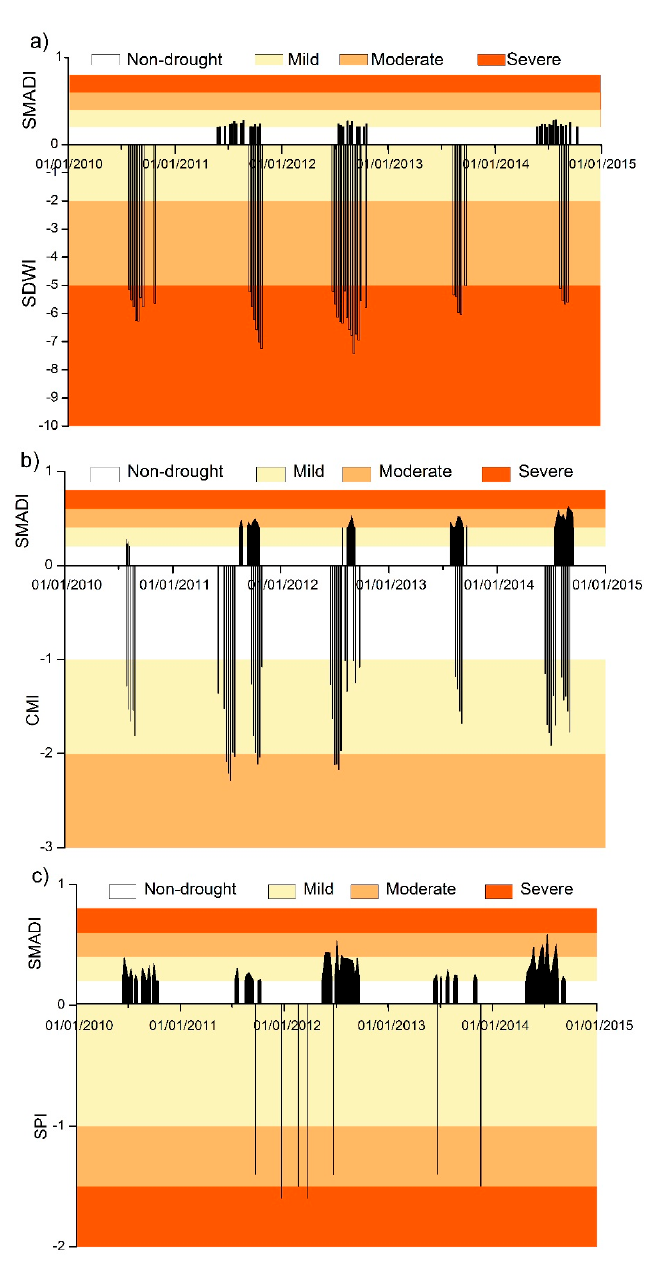
Figure 9. Range and duration of the drought events following the different approaches of SMADI and SWDI in REMEDHUS ( a ); SMADI and CMI in Matacán ( b ); and SPI and SMADI in a dry-considered station at the IP, Granada ( c ).